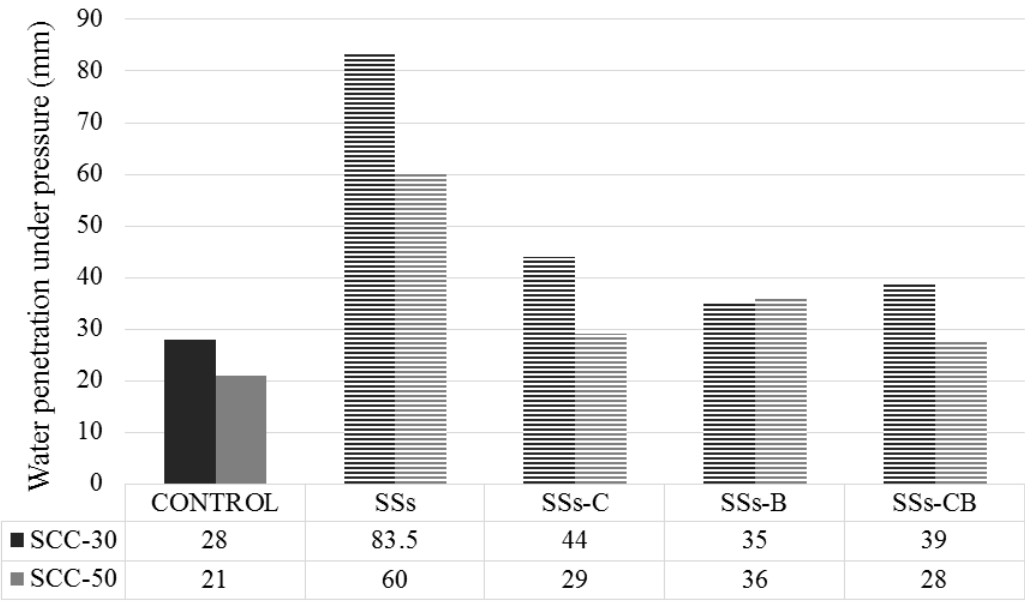
Figure 8. Water penetration under pressure at 28 days of SCC-30 and SCC-50.